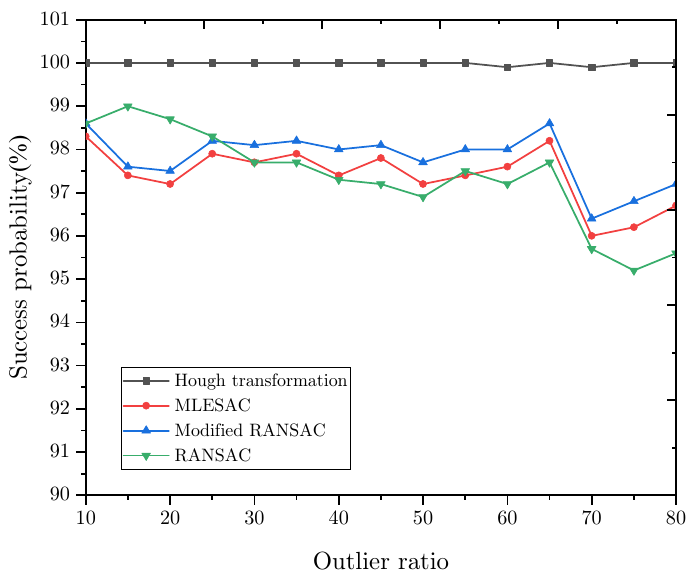
Figure 6. Success probability vs. the ratio of noisy